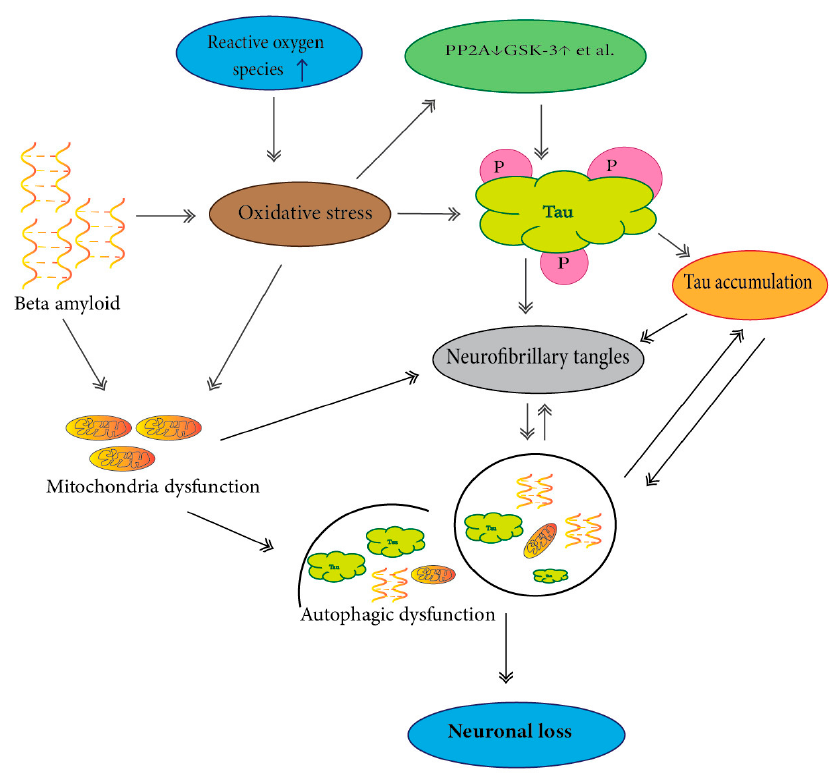
Figure 3. Dysfunction of autophagy and tau protein neurofibrillary tangles (NFTs) in the hippocampus of AD. Oligomeric A β -induced ROS production results in oxidative damage and mitochondrial dysfunction, in which hyperphosphorylated tau protein and NFTs produce through dysfunction, in which hyperphosphorylated tau protein and NFTs produce through an imbalance an imbalance of various protein kinases and phosphatases. These events lead to autophagic dysfunction and aggregated tau protein to neuronal loss in Alzheimer’s disease.